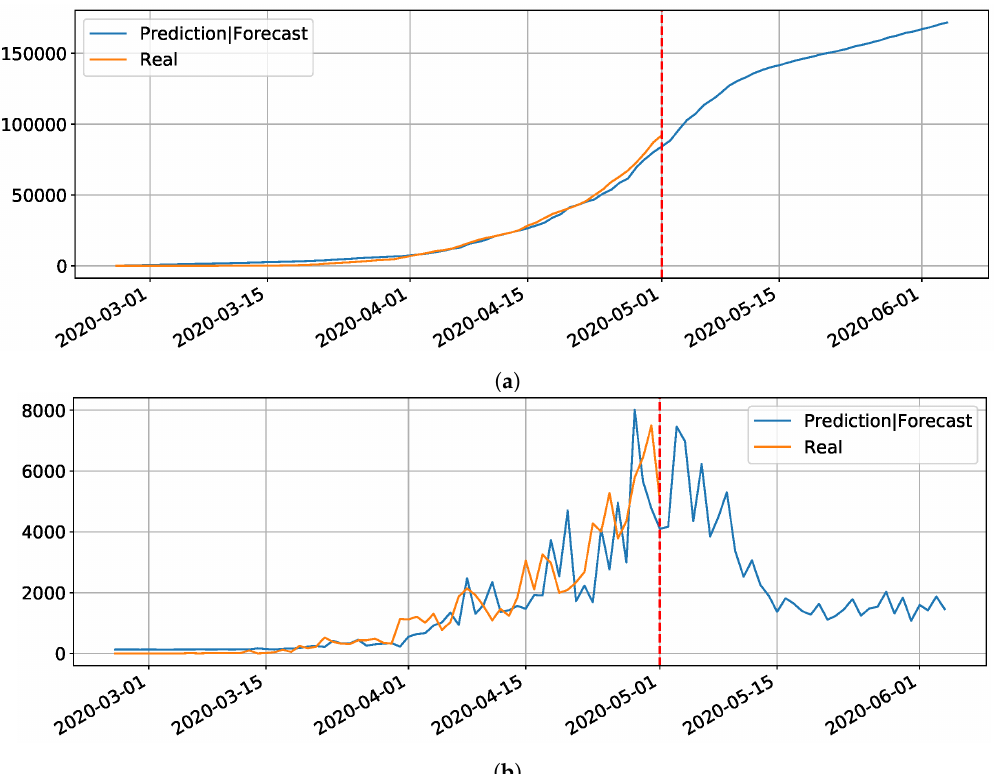
Figure 9. Predictions and forecasting to Brazil on Covid-19 cumulative ( a ) and daily ( b